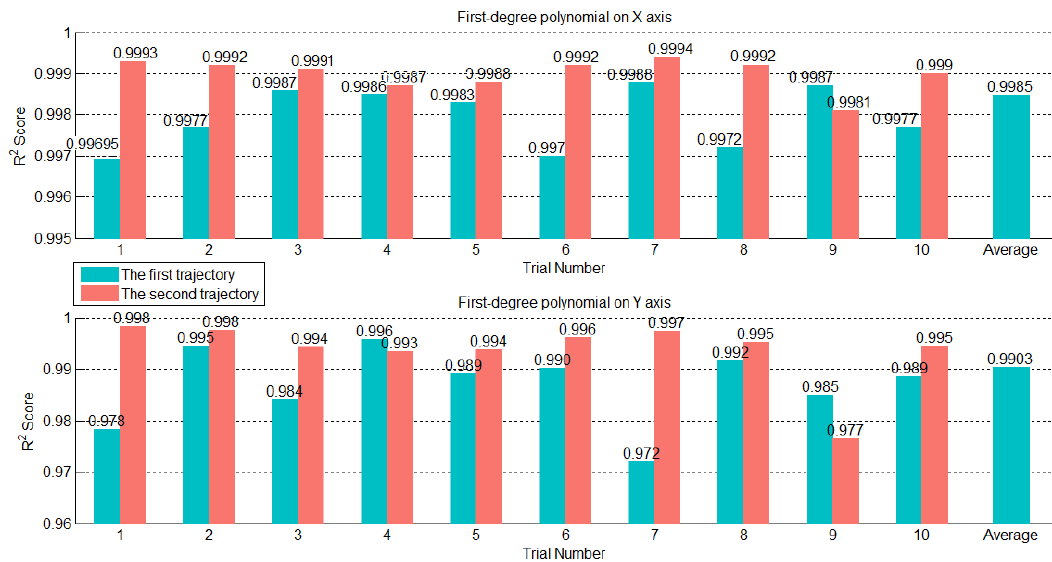
Figure 11. Diagram of trajectory prediction.